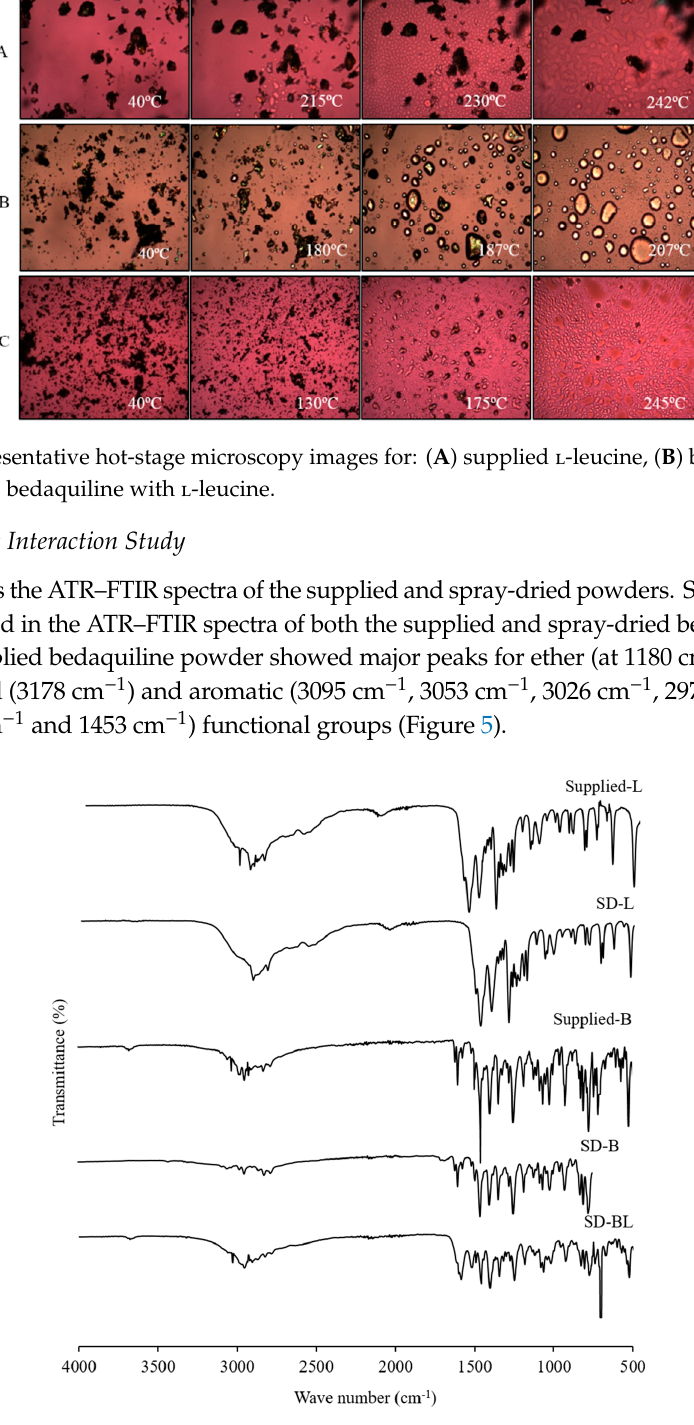
Figure 5. Attenuated total reflectance–Fourier transform infrared (ATR–FTIR) spectra of supplied L - leucine and bedaquiline and spray-dried powders of bedaquiline with and without L -leucine (L and B mean L -leucine and bedaquiline; SD means spray-dried; BL means bedaquiline with 20% w/w of L -leucine). Table 2. Aerosolization performance of the spray-dried bedaquiline (with or without L -leucine) powders.